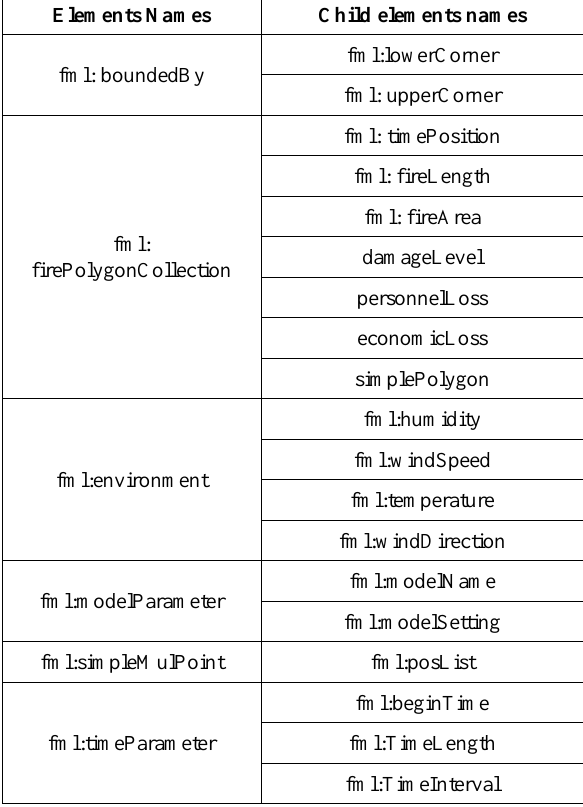
Table 2. The main elements of output document